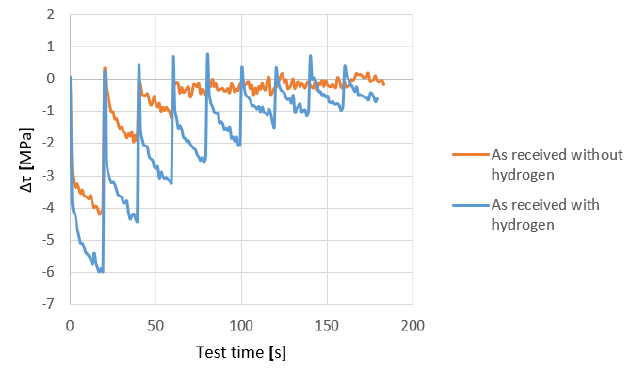
Figure 8. Stress- relaxation test of Fe in the as received state.